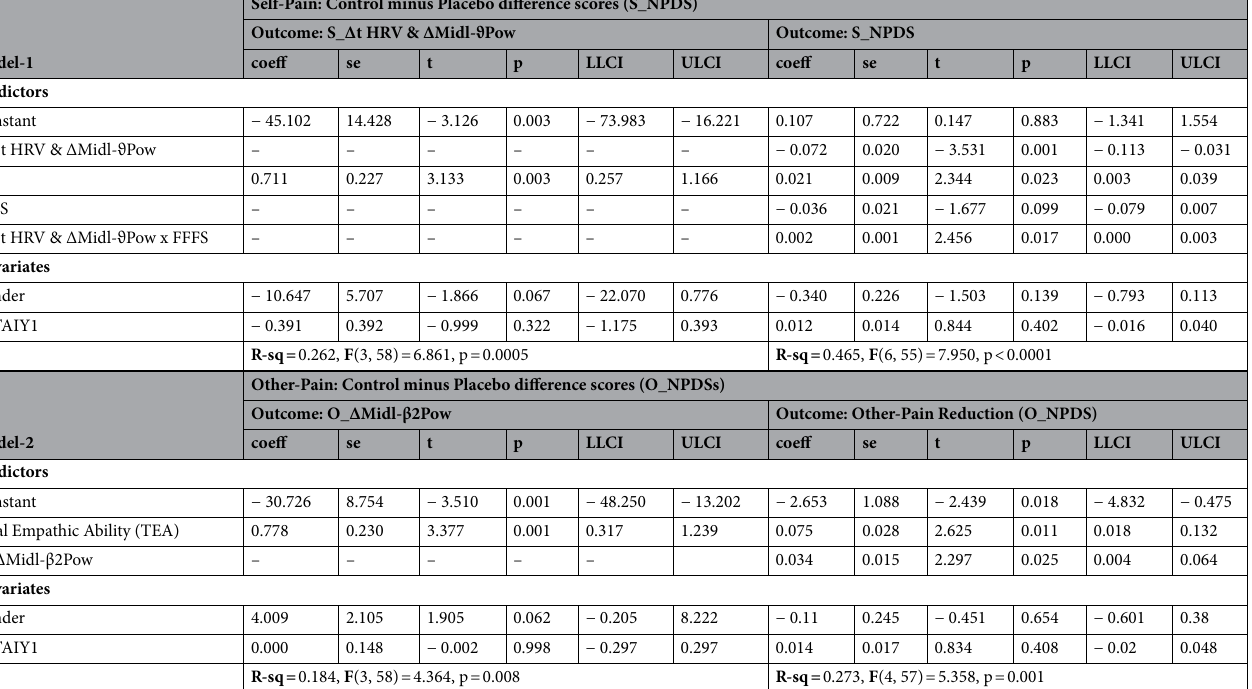
Table 6. Upper quadrant—Model-1: conditional process analysis using "S_∆tHRV & ∆Midl-ϑPow" as a potential mediator of the causal influence of BIS on the outcome of self-pain changes (S_NPDS) combined with FFFS as a moderator of the S_∆tHRV & ∆Midl-ϑPow influence on S_NPDS. Bottom quadrant: Model-2: simple mediation model testing the contribution of Total Empathic Ability (TEA) as a potential causal factor influencing changes in other-pain rating scores (O_NPDS) through its indirect influence of O_ΔMidl-β2Pow factor as a mediator causing other-pain changes as the final consequent. Gender and State-anxiety differences (ΔSTAIY1) are entered as covariates in both